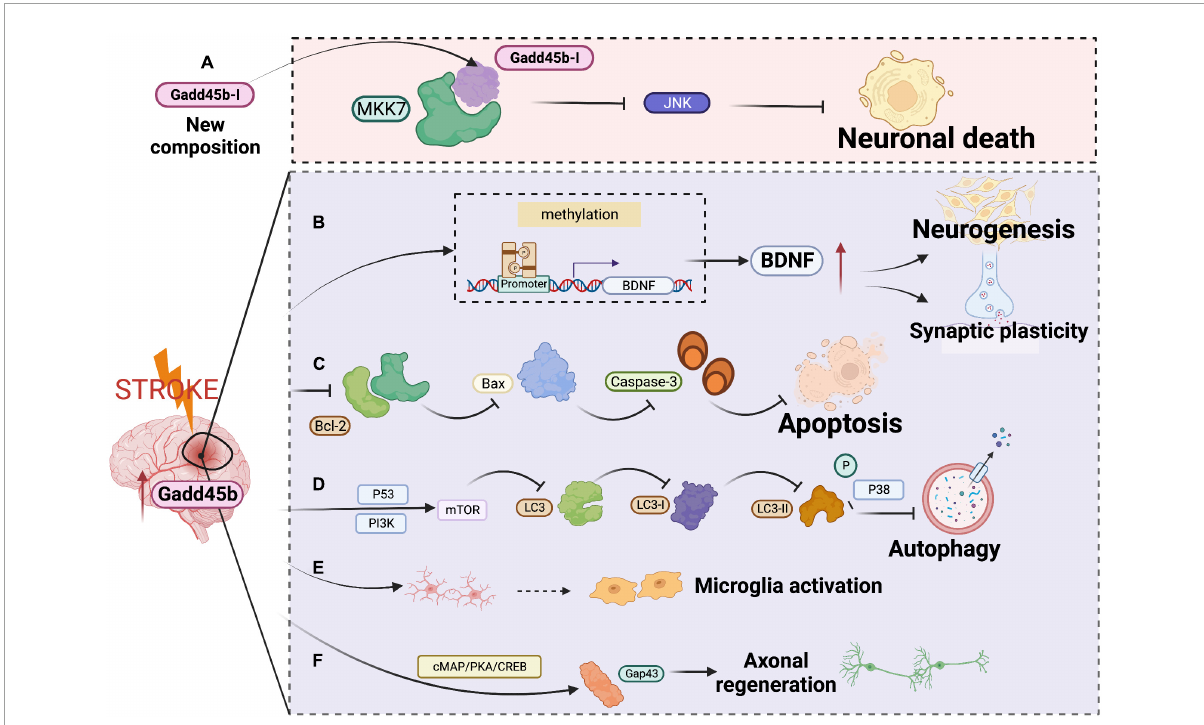
FIGURE5 Roles of growth arrest and DNA damage-inducible beta (Gadd45b) in cerebral ischemic disease. (A) Gadd45b-I specifically binds to MKK-7 and inhibits JNK-mediated neural death. (B) Gadd45b promotes neurogenesis and synaptic remodeling by altering the demethylation of BDNF. (C) Gadd45b decreases the release of Bcl-2 and Bax to inhibit apoptosis. (D) Gadd45b inhibits cellular autophagy by stimulating PI3K/P53 signaling pathway and suppressing the P38 signaling pathway. (E) Gadd45b may be associated with microglia polarization. (F) Gadd45b promotes axonal regeneration through the camp/PKA/CREB signaling pathway (Figure was created with BioRender.com).